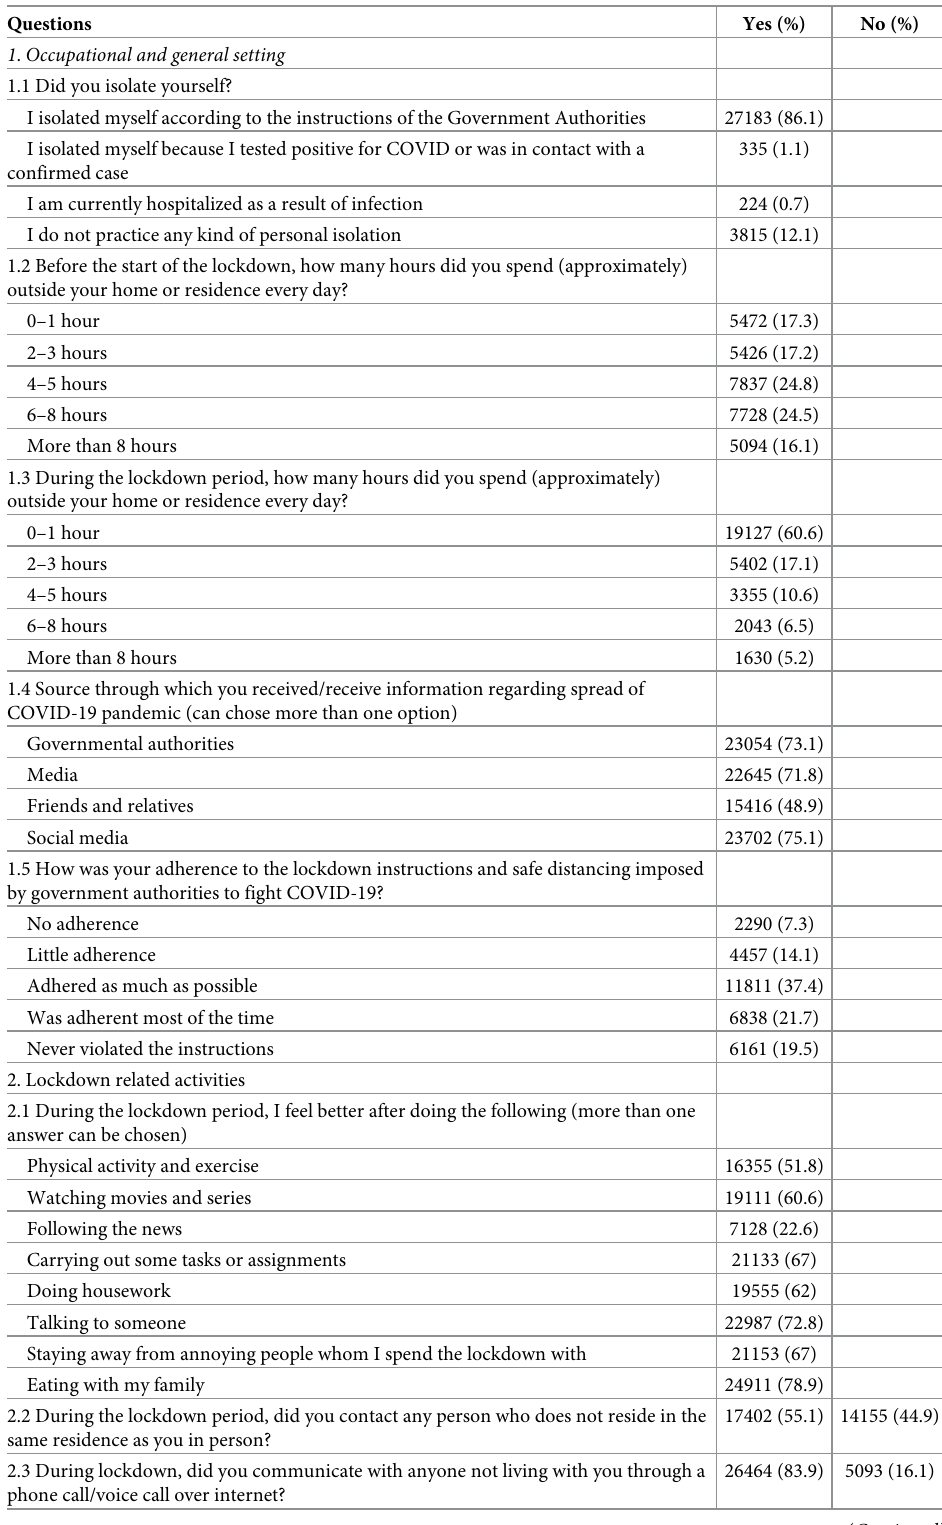
Table 2. Survey on impact of lockdown implemented owing to